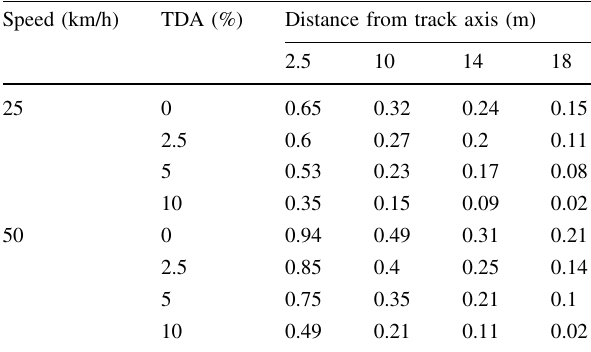
Fig. 4 A sample of velocity–time results for the draisine at 2.5 m distance from track axis Table 3 V RMS results under the passage of the draisine (mm/s) Speed